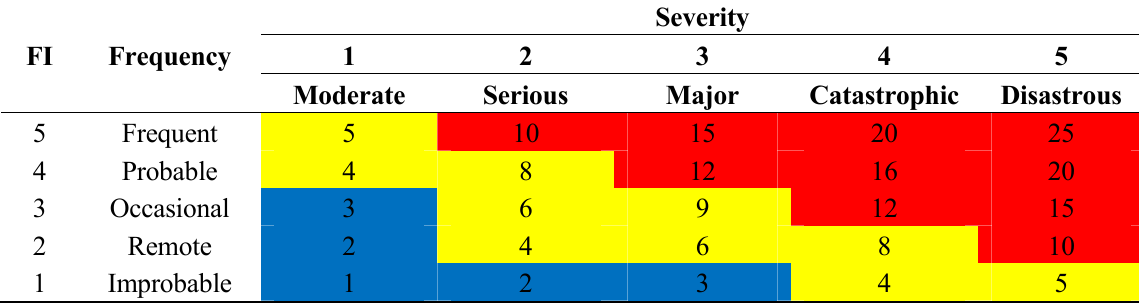
Table 6. Risk matrix to risk assessment in NGH ship